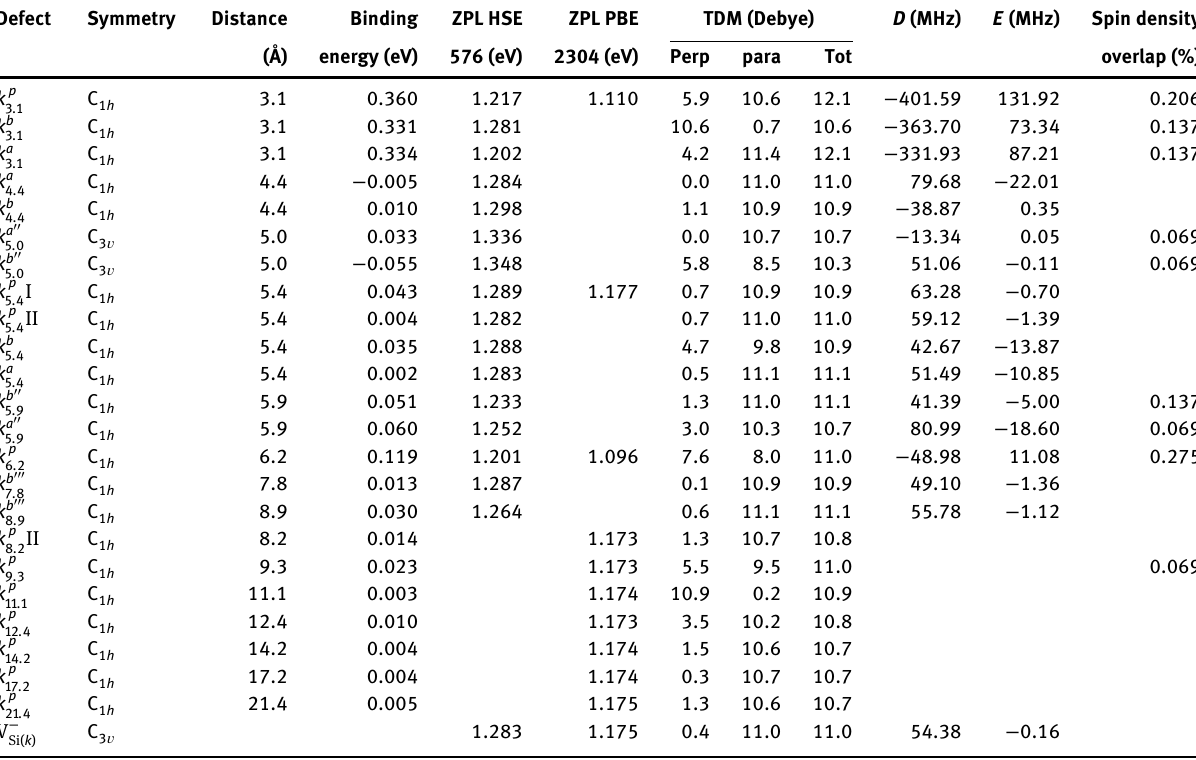
Table 2: The data for all the modified vacancy k configurations. Each configuration is denoted with the symmetry and distance between the silicon vacancy and carbon antisite as well as binding energy. The magneto-optical properties include ZPL (for both 576 atom super cell with the HSE functional and the 2304 super cell with the PBE functional), TDM, D , and E values.